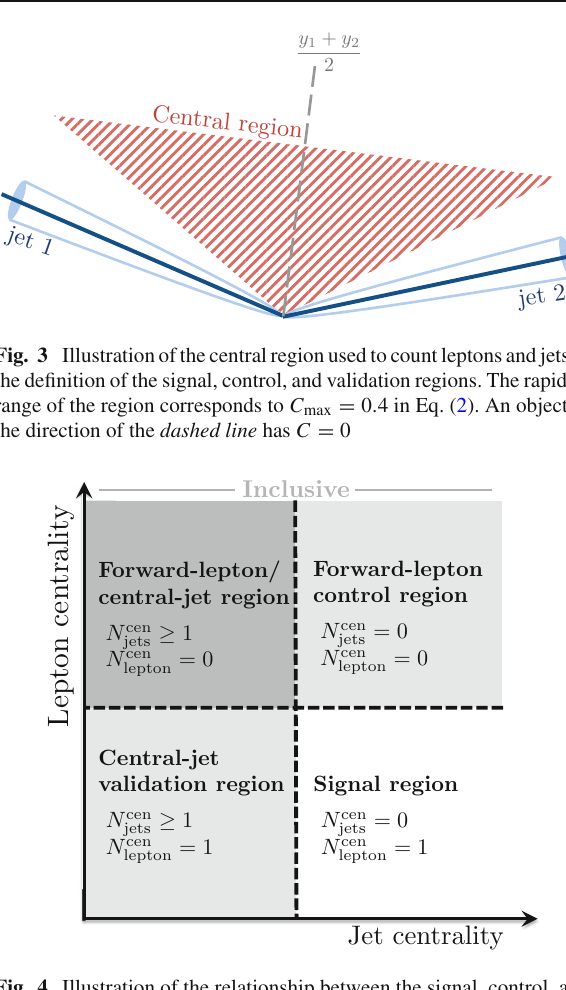
Fig. 4 Illustration of the relationship between the signal, control, and validation fiducial regions. The signal region is defined by both a veto on additional jets (beyond the two highest- p T jets) and the presence of a lepton in the rapidity region defined in Eq. (2). The signal region is studied with either M jj > 0 . 5 TeV or 1 TeV. A forward-lepton/central- jet fiducial region is also defined, for which the centrality requirements on the jets and the lepton are inverted with respect to the signal region. The inclusive region corresponds to the union of all four regions, and is studied with M jj > 0 . 5 , 1 . 0 , 1 . 5 , or 2.0TeV. The quantities N cen N cen refer to the number of reconstructed leptons and additional jets lepton reconstructed in the rapidity interval defined by Eq. (2) and illustrated in Fig. 3, with C max = 0 .